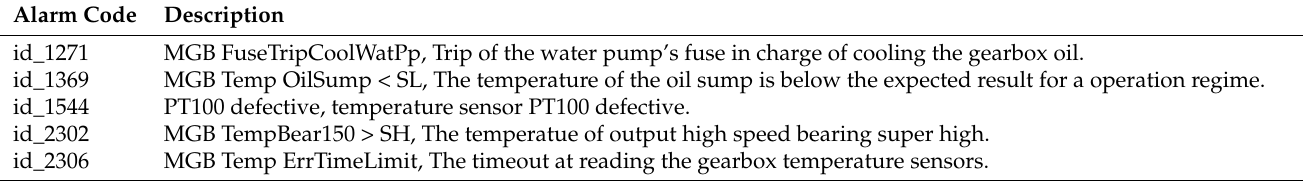
Table 4. Description of the error